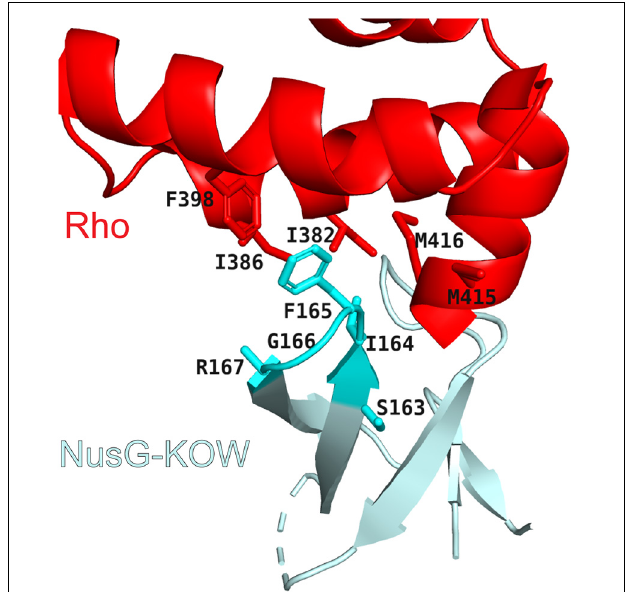
FIGURE 3 | Rho/NusG-KOW interface. Rho residues that contact NusG are shown as red sticks. NusG KOW residues implicated in Rho and S10 binding are shown as cyan sticks; PDB ID: